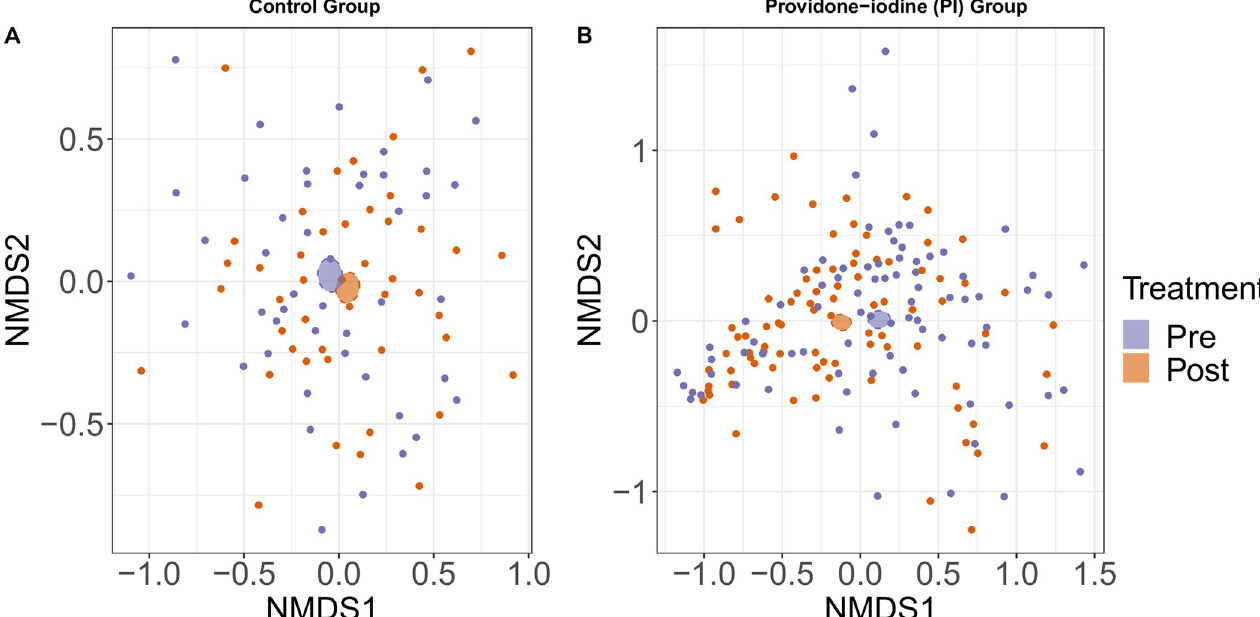
Fig 4. Beta diversity of bacterial community composition. Differences of nasal bacterial community compositions across treatments groups. Non-metric multidimensional scaling (nMDS) plot of the Bray-Curtis dissimilarity for bacterial community of nasal samples collected pre- and post-surgery from (A) control group and (B) povidone-iodine group. Ellipses illustrates standard error around centroid of pre- and post- nasal community samples in each treatment group and colored by treatment. P- value < 0.05 was considered a significant difference between bacterial community composition between pre- and post- surgery samples. The nMDS stress levels for PI group = 0.20 and control group =